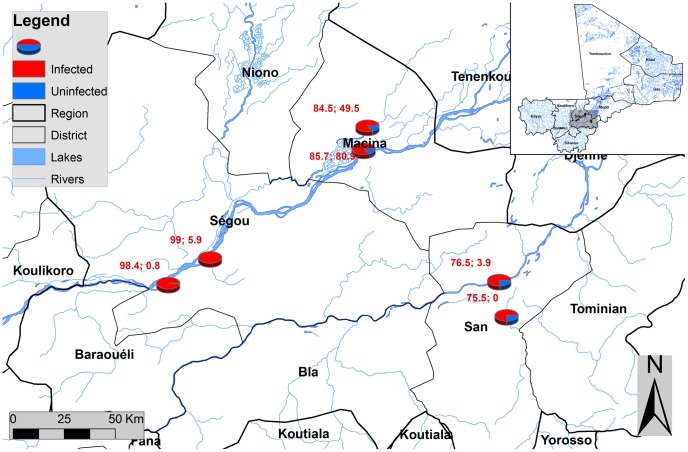
Geographical locations of survey sites in three districts in Segou region, Mali.The figures shown for each survey site in the map are the baseline prevalence of S. haematobium (the former) and S. mansoni (the latter).